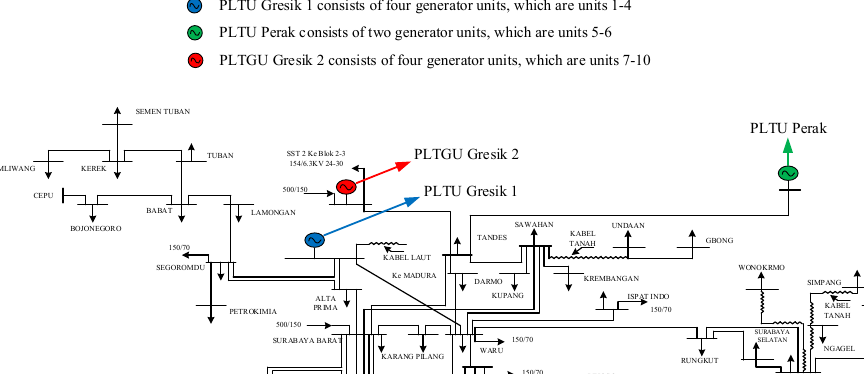
Figure 1. Location of the East Java 150 kV power system.